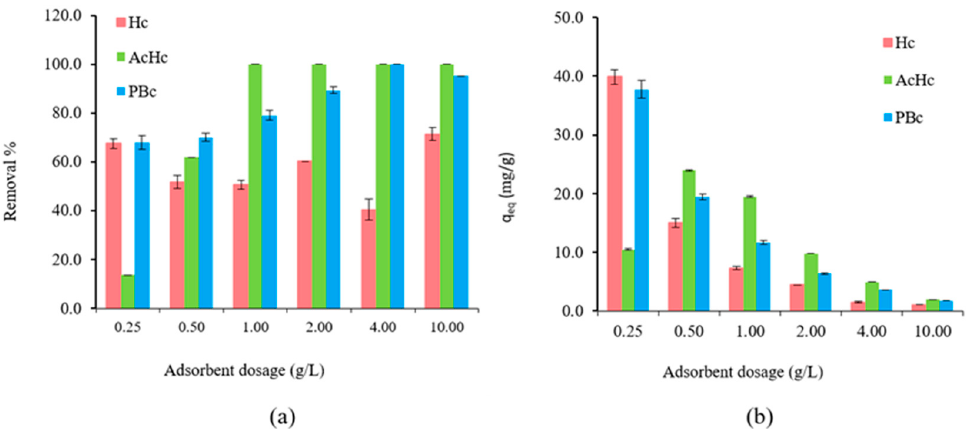
Figure 7. Removal efficiency ( a ) and adsorbed amount ( b ) ( ± global uncertainty) by PBc, Hc, and AcHc at different adsorbent concentrations, C 0 = 20 mg/L Pb(II), pH = 5 ± 0.5, T = 23 ± 1 °C, 4 h contact time.